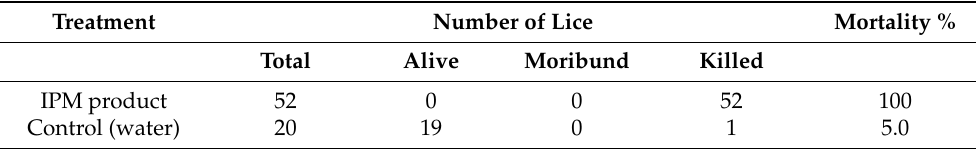
Table 4. Effect of in vitro immersion of lice in the isopropyl myristate product. Treatment Number of